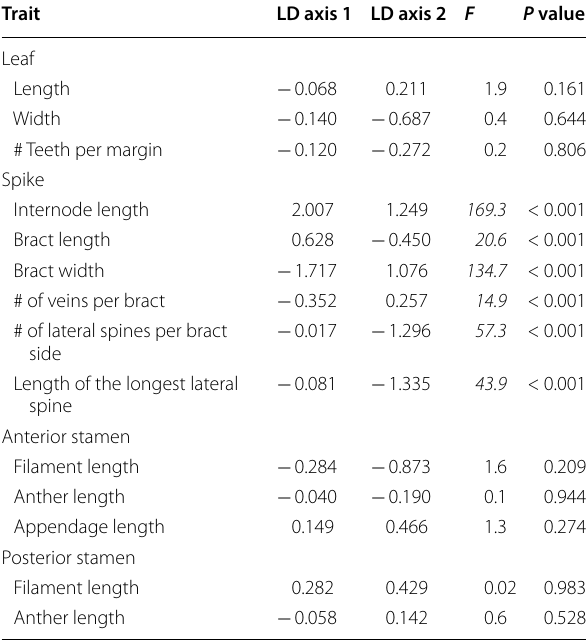
Table 1 Linear discriminant (LD) axis loadings of 14 morphological characteristics measured in Blepharis plants from three populations in